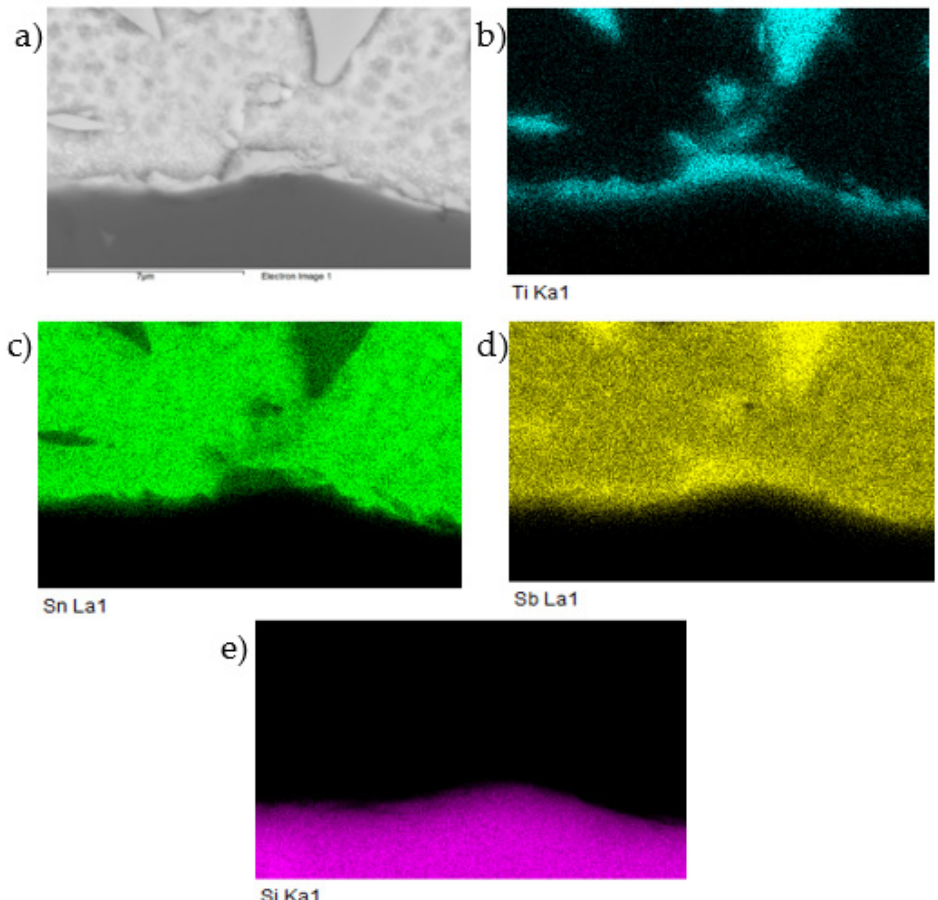
Figure 19. Planar distribution of Ti, Sn, Sb, and Si elements in the boundary of the SiC/Sn5Sb3Ti joint; SEM photo of ( a ) the boundary, ( b ) Ti, ( c ) Sn, ( d ) Sb, and ( e ) Si.